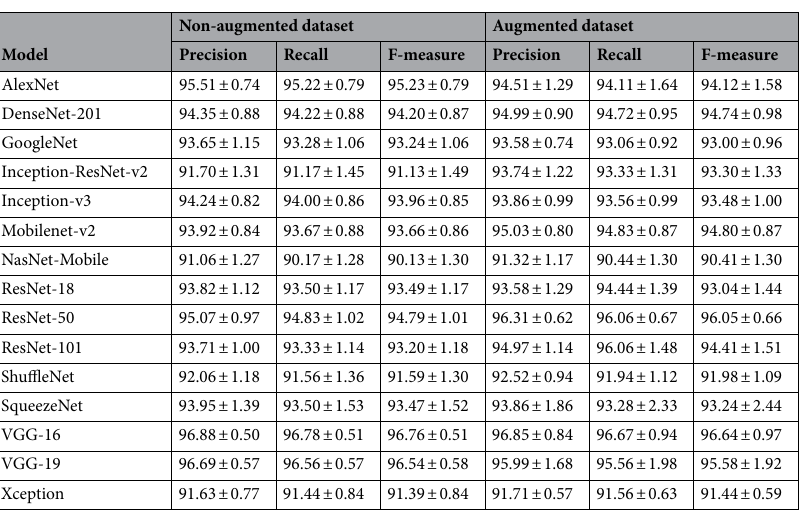
Table 3. Performance on the test set of the model with the non-augmented dataset and the models with the augmented dataset (model) (mean ± standard deviation %).